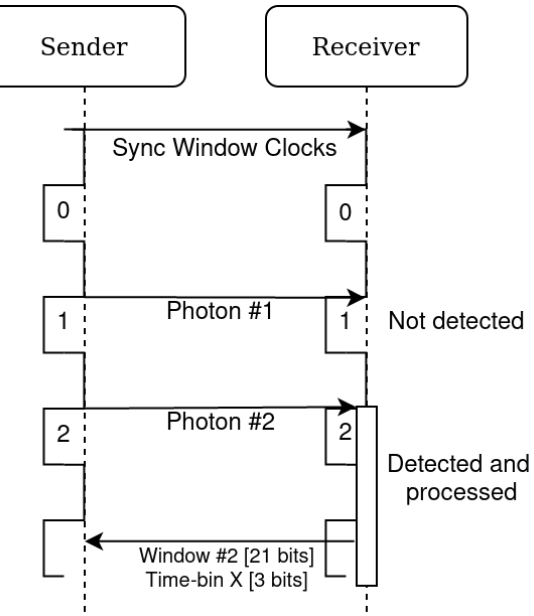
Figure 7. Diagram of the use of the Window field of the dataframe to synchronize the photons sent and received. The initial synchronization of the window clocks could be decided via a sequence of bright pulses or another absolute time reference. This synchronization of the window clock needs be done periodically to compensate for drifting.